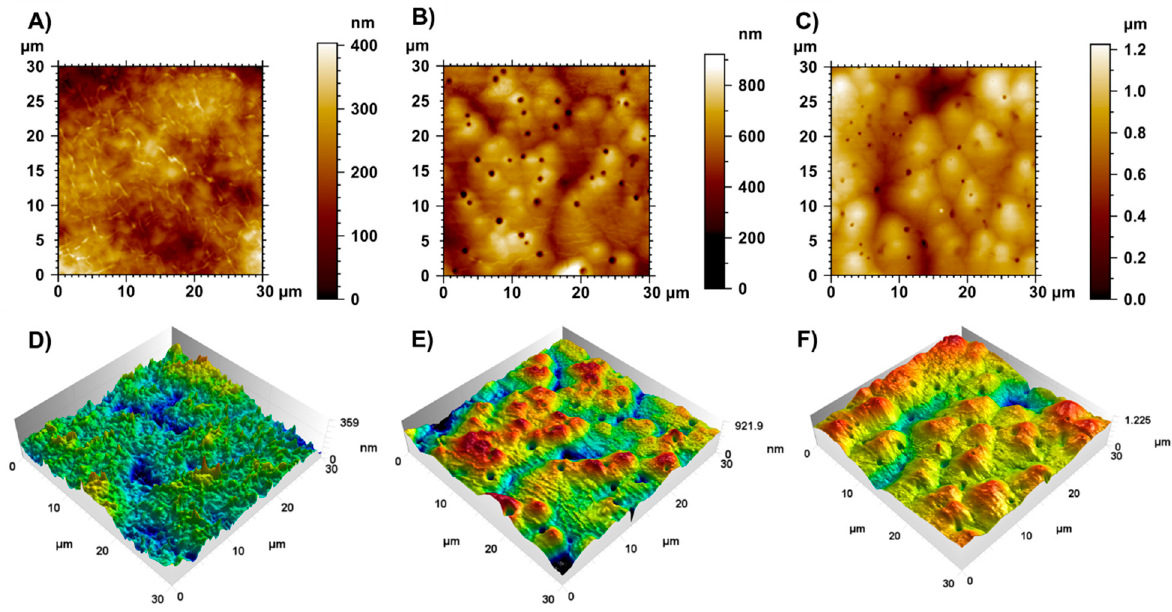
Figure 6. Atomic force microscopy height map of the pure (127-Pluronic) nanomicelles film ( A ), 127- Pluronic-[ 223 Ra]RaCl 2 nanomicelles film ( B ), and [ 223 Ra]RaCl 2 co-loaded with [ 198 Au]AuNPs film ( C ), and their respective three-dimensional topographies (images ( D – F )). The increase in height scale bar values indicates the filling of the 127-Pluronic nanomicelles with 223 Ra and 223 Ra + [ 198 Au]AuNPs.